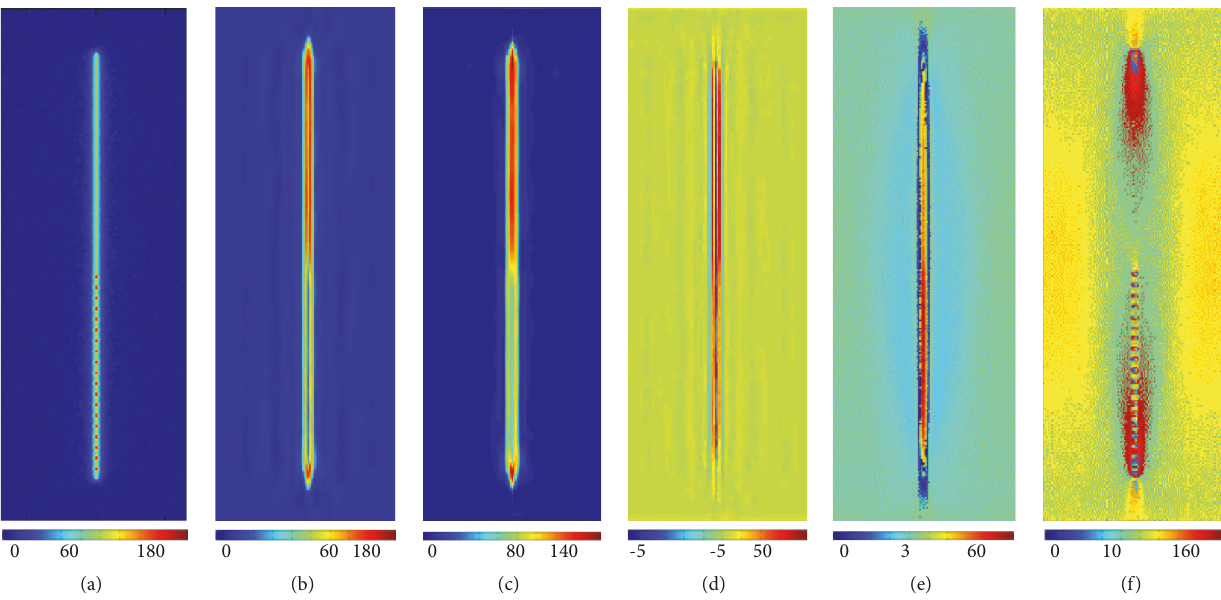
Figure 3: Extraction results for the simulated image obtained using our method. (a) Original simulated image. (b) The 40th subimage after convolution. (c) Cartoon layer of the 40th subimage after decomposition and denoising. (d) Texture layer of 40th subimage after decomposition and denoising. (e) Reconstructed filaments. (f)